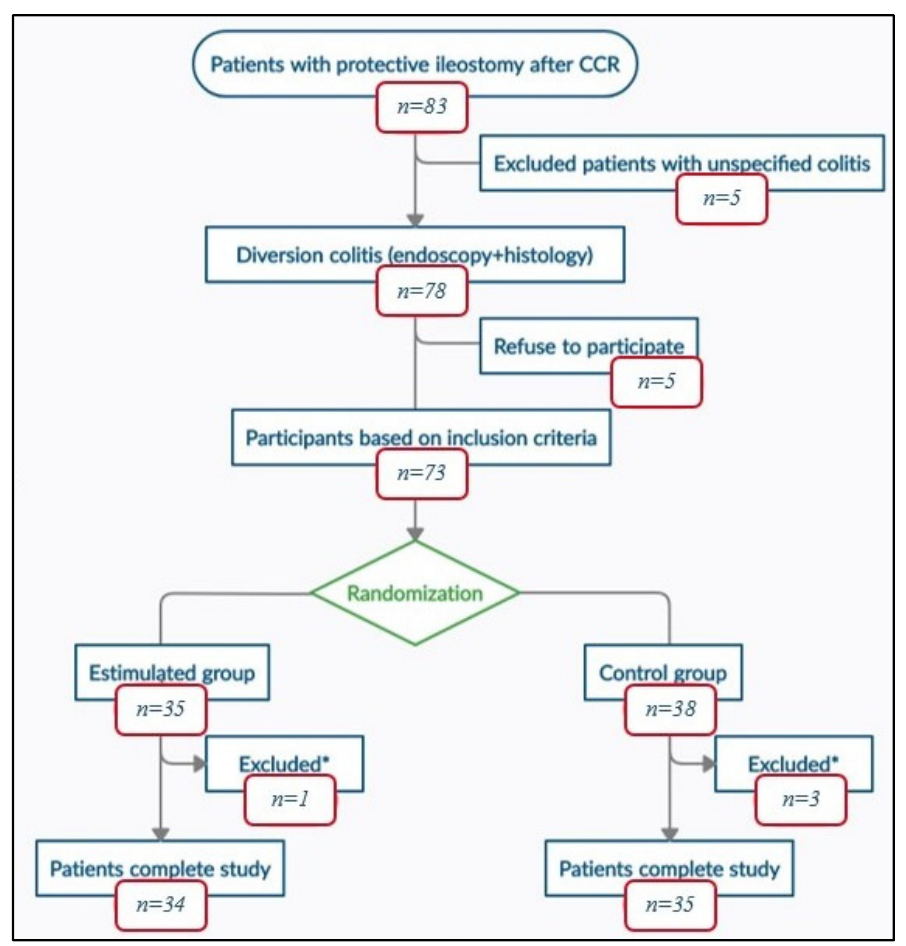
Figure 1. Study flowchart; CRC: Colorectal Cancer; *: excluded patients with anastomotic leak. The inclusion criteria were being over 18 years of age, having protective ileostomy after colorectal carcinoma surgery free of disease, with endoscopic and histological confirmation of diversion colitis and having signed the informed consent. As exclusion crite-